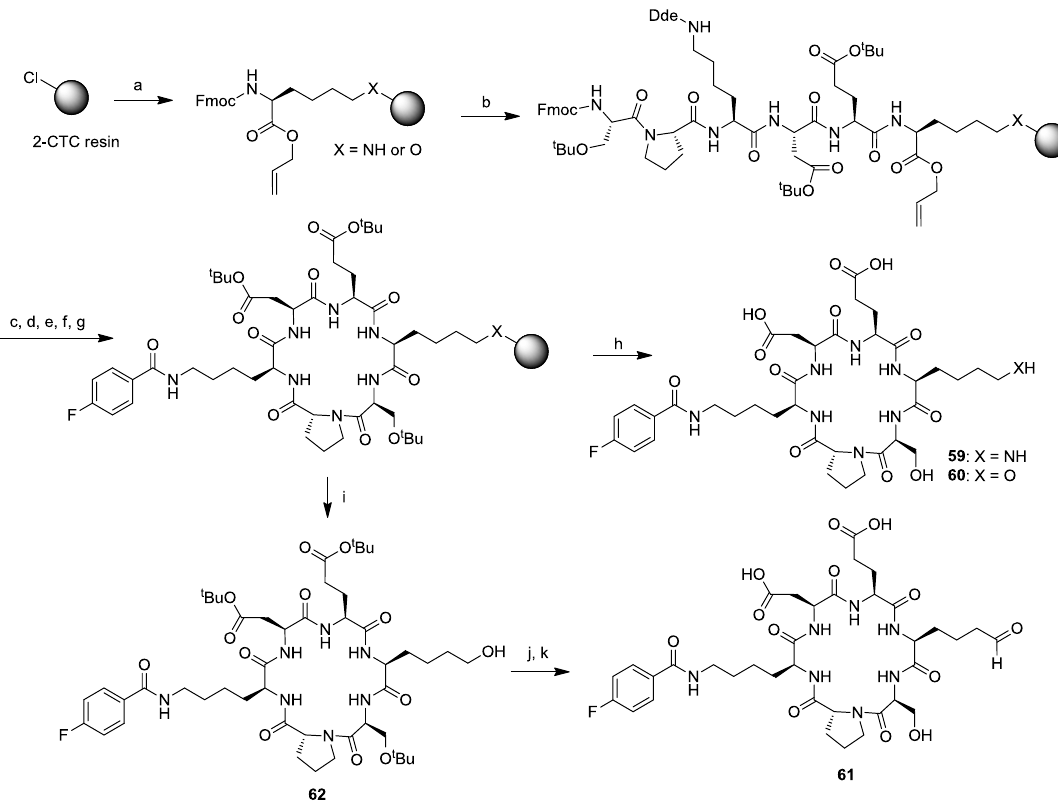
Scheme 11. Solid-phase peptide synthesis of 59–62 on 2-chlorotrityl chloride (2-CTC) resin.